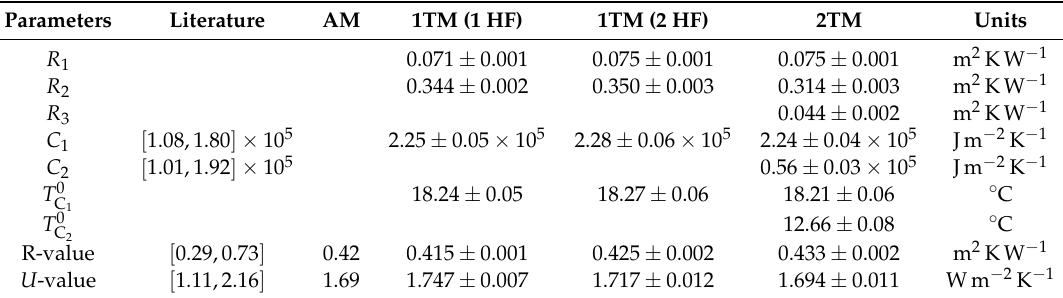
Table 1. Thermophysical properties for the SWall for the average (AM) and dynamic (using the 1TM (1HF), 1TM (2HF), and the 2TM models) method. Only the statistical error is shown, and the number of significant figures was chosen to illustrate the level of the